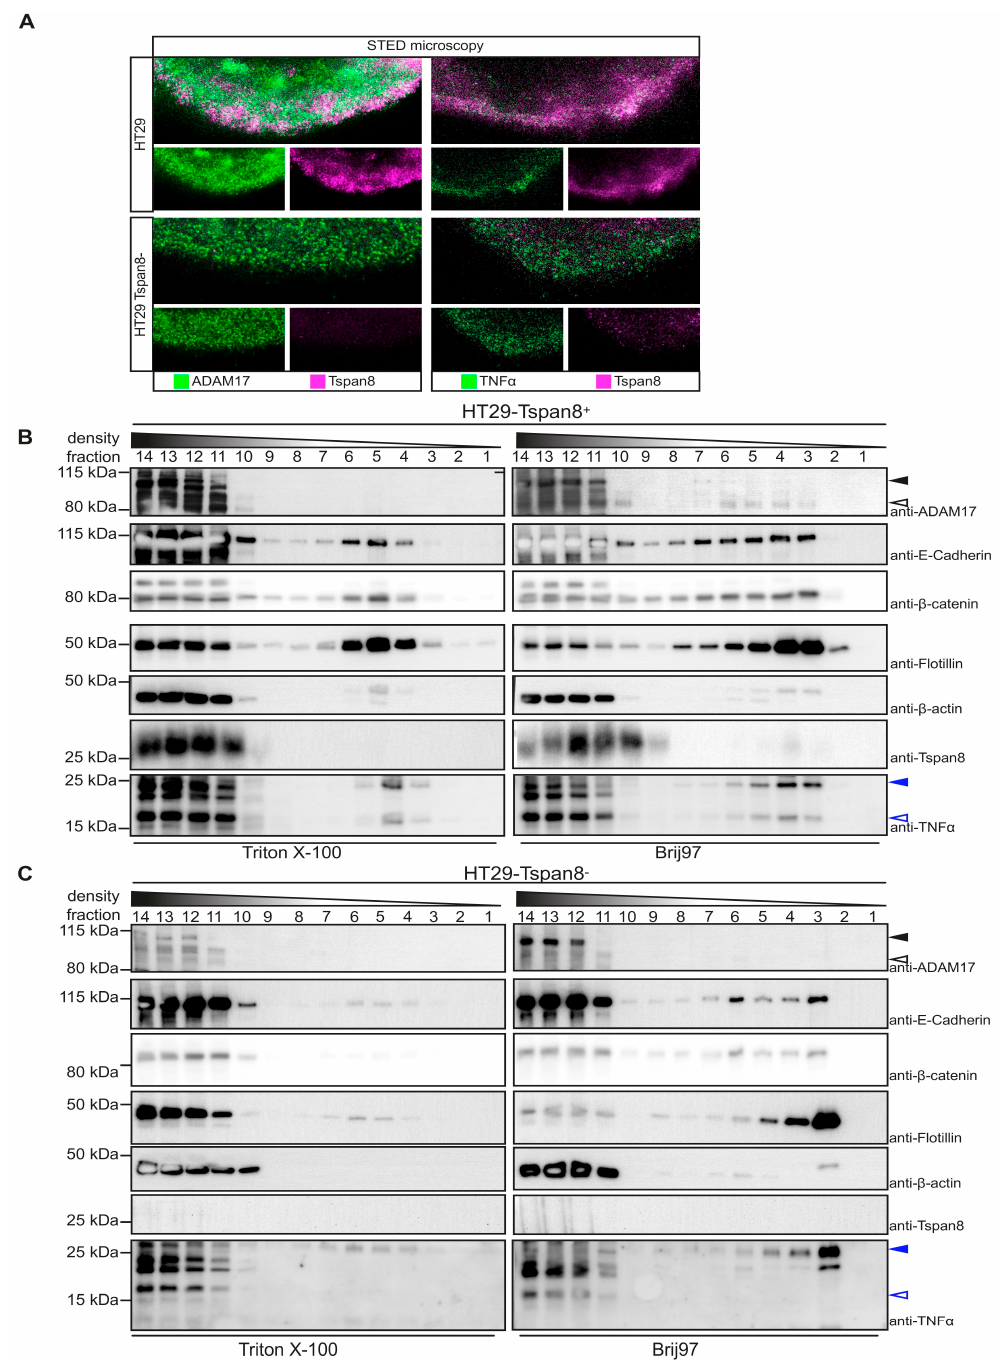
Figure 5. Tetraspanin 8 mediates TNF α shedding by ADAM17 in tetraspanin-enriched microdomains (TEM). ( A ) Stimulated Emission Depletion (STED) microscopy reveals presence of both ADAM17 and TNF α in Tspan8+ membrane microdomains. One representative out of three independent experiments is shown. ( B , C ) Tspan8 promotes recruitment of ADAM17 into tetraspanin-enriched microdomains. Parental ( B ) or Tspan8-deficient ( C ) HT29 cells were lysed with the indicated detergents and subjected to differential density centrifugation using a sucrose gradient. Flotillin served as a marker for lipid rafts in Triton X-100 lysed cells. Tetraspanin-enriched microdomains migrated at the same density as flotillin, as indicated by the presence of Tspan8 in HT29 cells. Black filled arrow heads: ADAM17 pro-form, black open arrow heads: ADAM17 mature form. Blue filled arrow heads: pro-TNF α , blue open arrow heads: processed TNF α . One representative out of three independent experiments is shown.